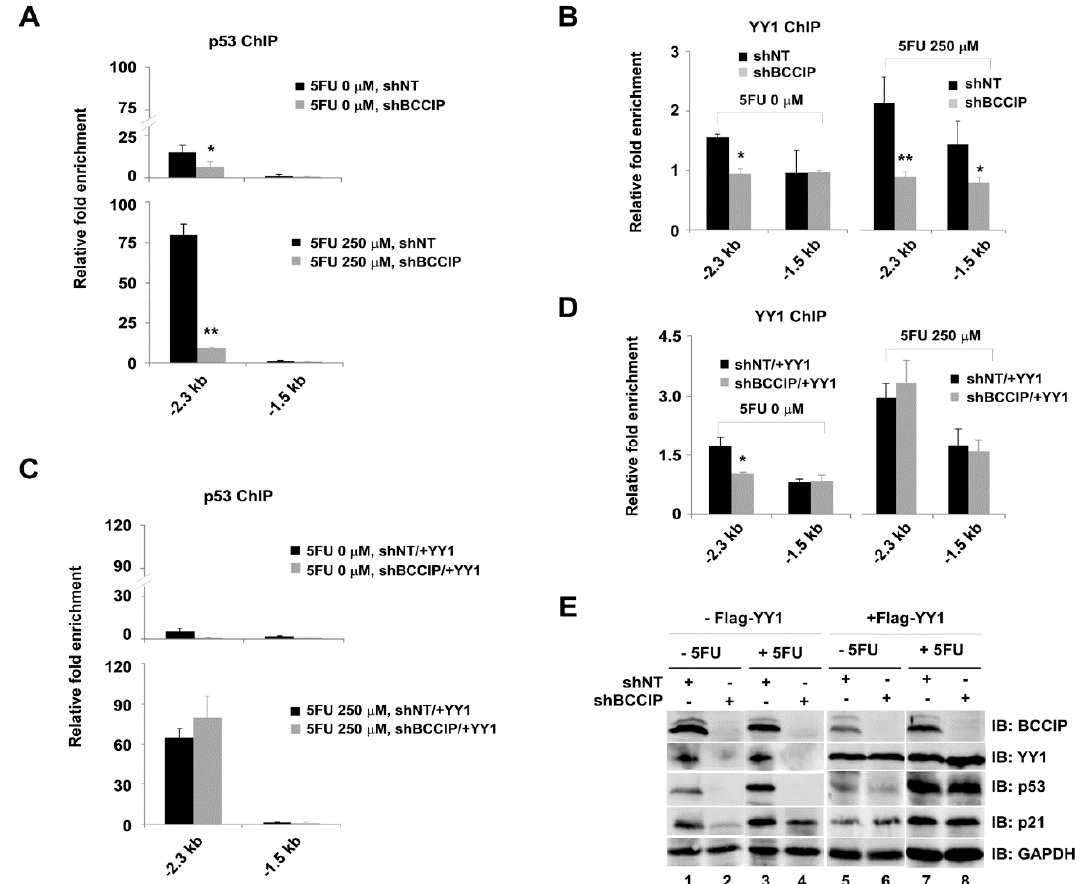
Figure 8. YY1 and BCCIP coregulation of p53 target gene p21 in shBCCIP-treated HCT116 cells. BCCIP knockdown cells with or without 5FU exposure were used in the following ChIP experiments. ( A , B ) p53 and YY1 ChIP experiments were carried out using chromatin lysate in the presence of shNT or shBCCIP expressing cells. Chip DNA was analyzed with qPCR ( n = 3). ( C , D ) Rescue experiments. Stably expressing shNT or shBCCIP cells were transiently transfected with Flag-YY1 for 48 h. Then, prepared chromatin lysate was applied to ChIP assays. The y-axis shows the ratio of ChIP DNA signals to IgG, and all signals were normalized to input ( n = 3). * p < 0.05, ** p < 0.01, t -test, comparison to shNT group. ( E ) Indicated protein levels in A, B, C and D.